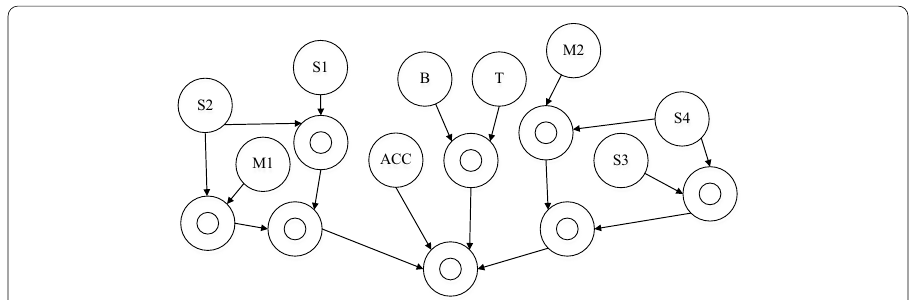
Fig. 19 BN model of ACC system